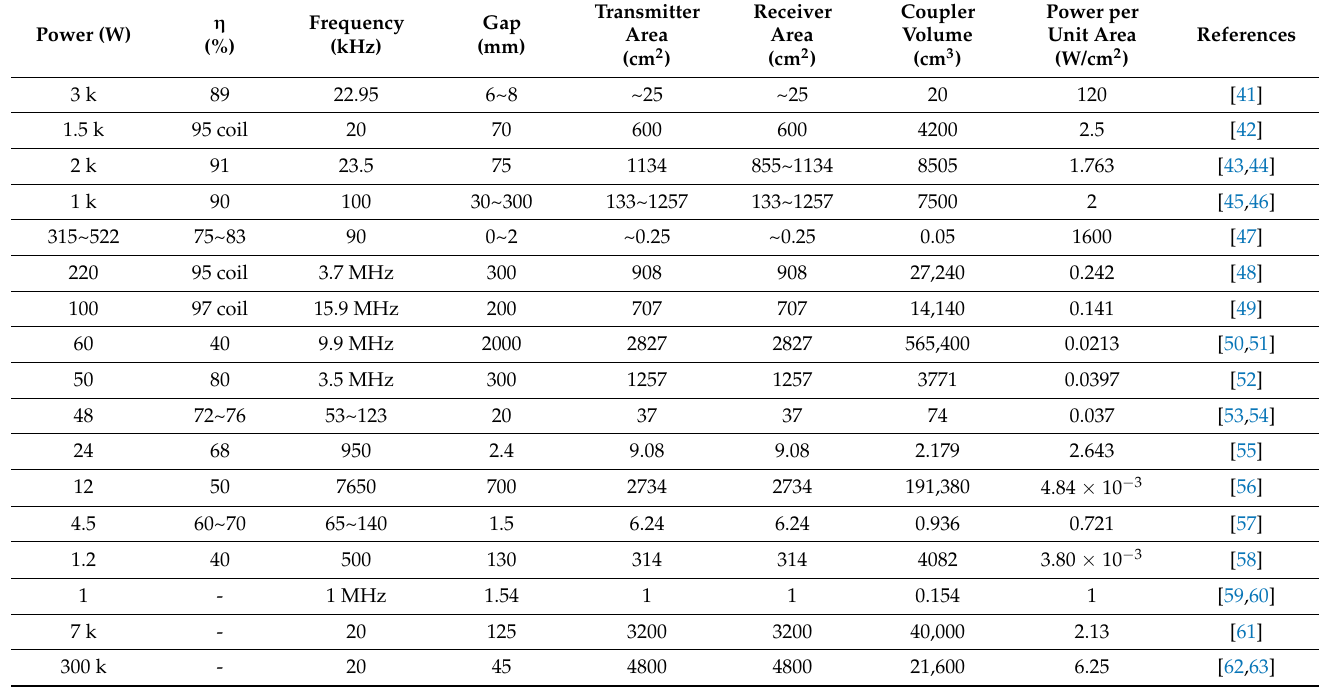
Table 1. Inductive Power Transfer